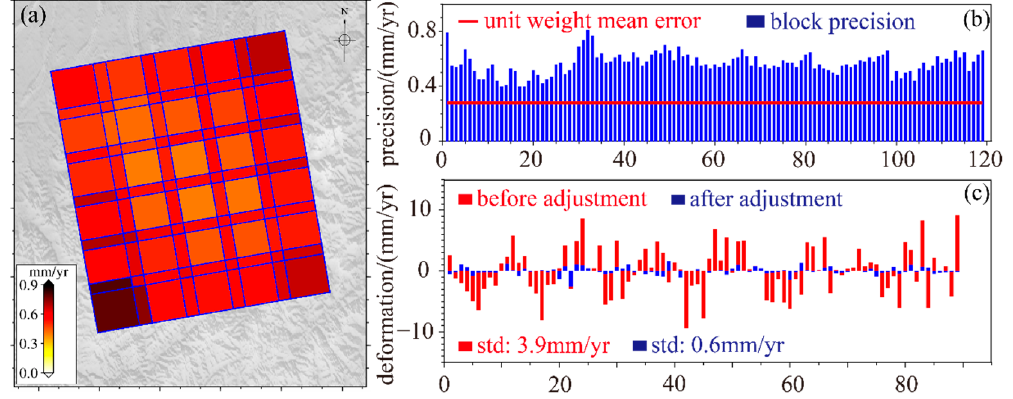
Figure 7. The same as Figure 6, but for Qijiang.